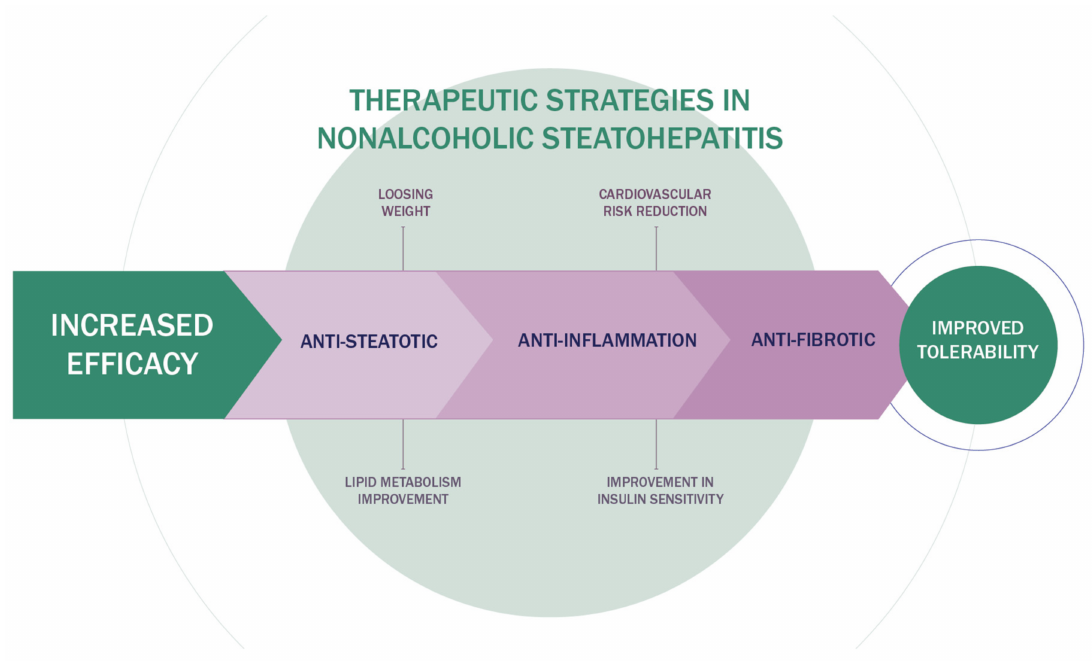
Figure 2. Therapeutic algorithm for NAFLD